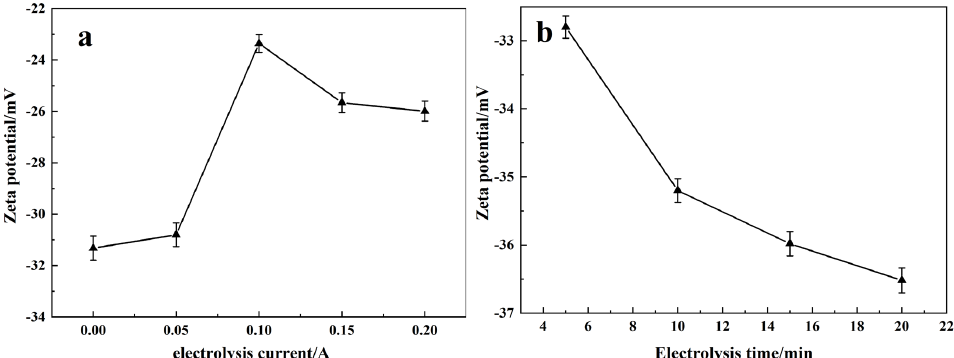
Figure 8. Effect of electrochemical pretreatment on zeta potential of the muscovite surface with Cu 2+ (pH = 12, c(Cu 2 + ) = 6 × 10 − 5 mol / L). ( a ), electrolysis current; ( b ), electrolysis time.